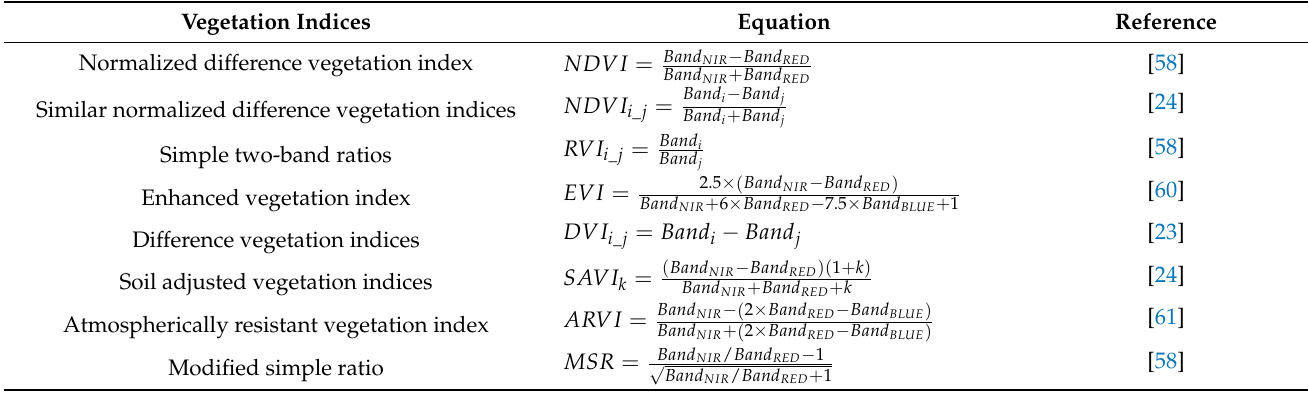
Table 3. Vegetation indices used in this research.